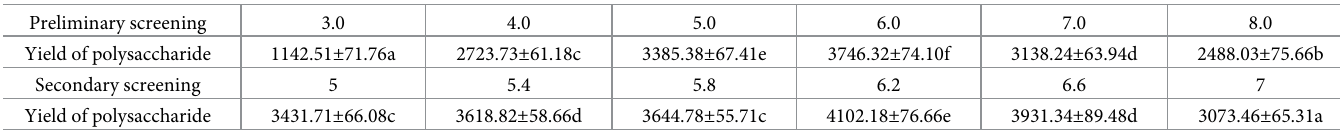
Table 3. Effect of different pH on the yield of MRYP